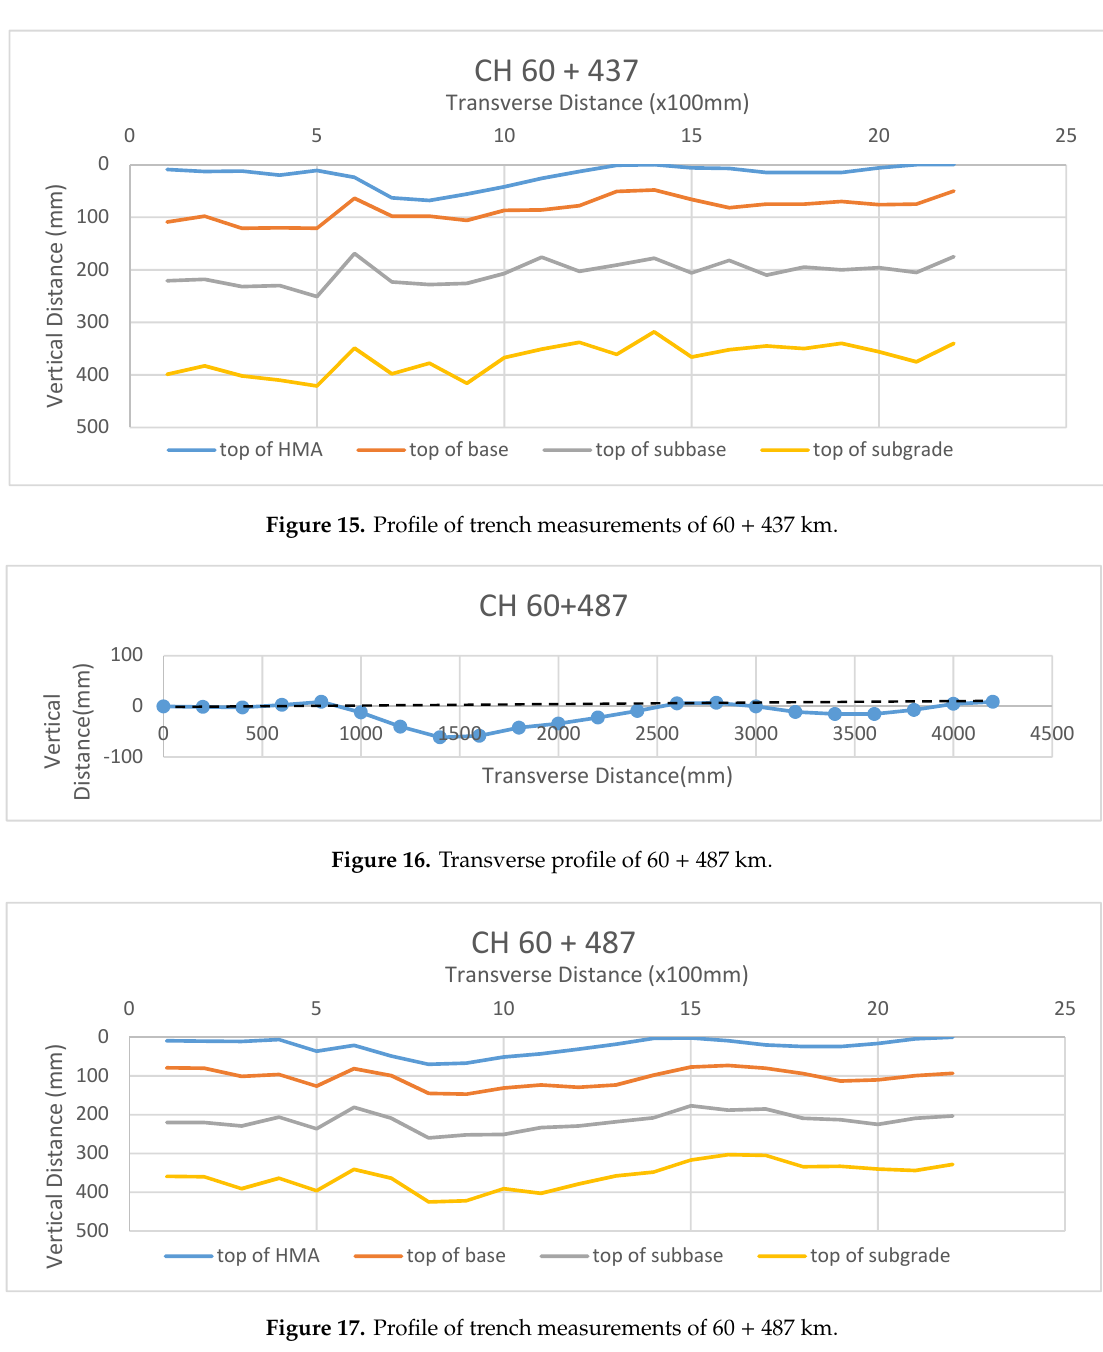
Figure 14. Transverse profile of 60 + 437 km.